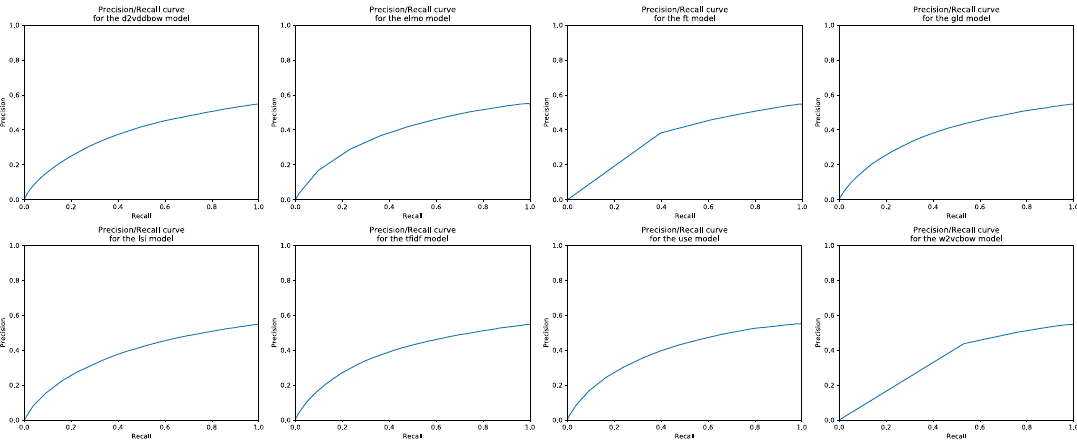
18 of 24 Figure A2. Receiver operator characteristic curves for eight models processing C&S corpus.